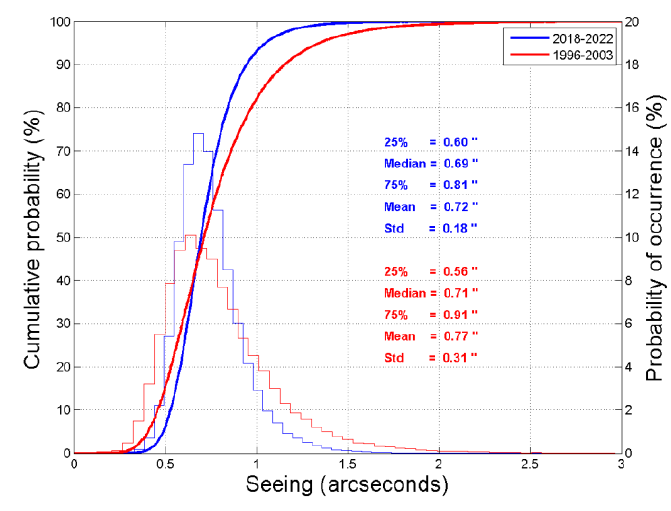
Figure 5. Cumulative distribution of seeing measured in 2018 – 2022 and 1996 – 2003. Table 2. Monthly seeing statistics for 2018–2022 and